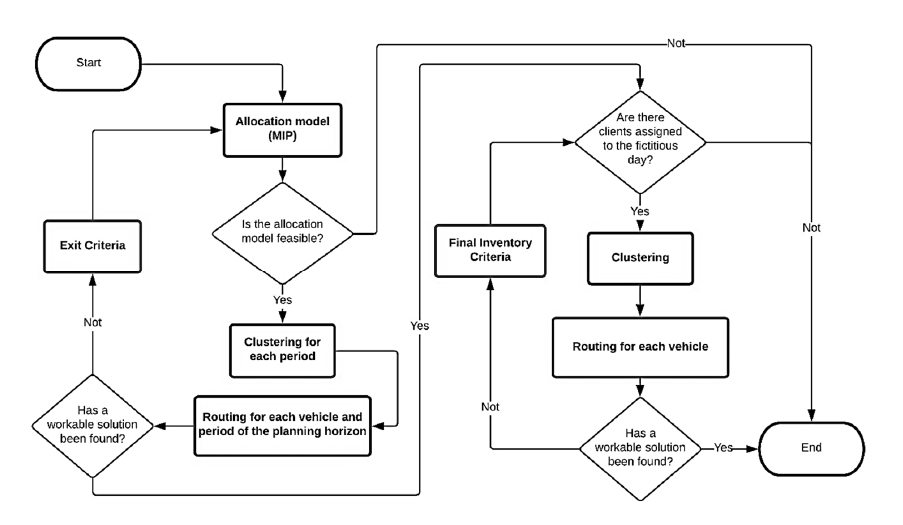
Fig. 1. Diagram of the proposed